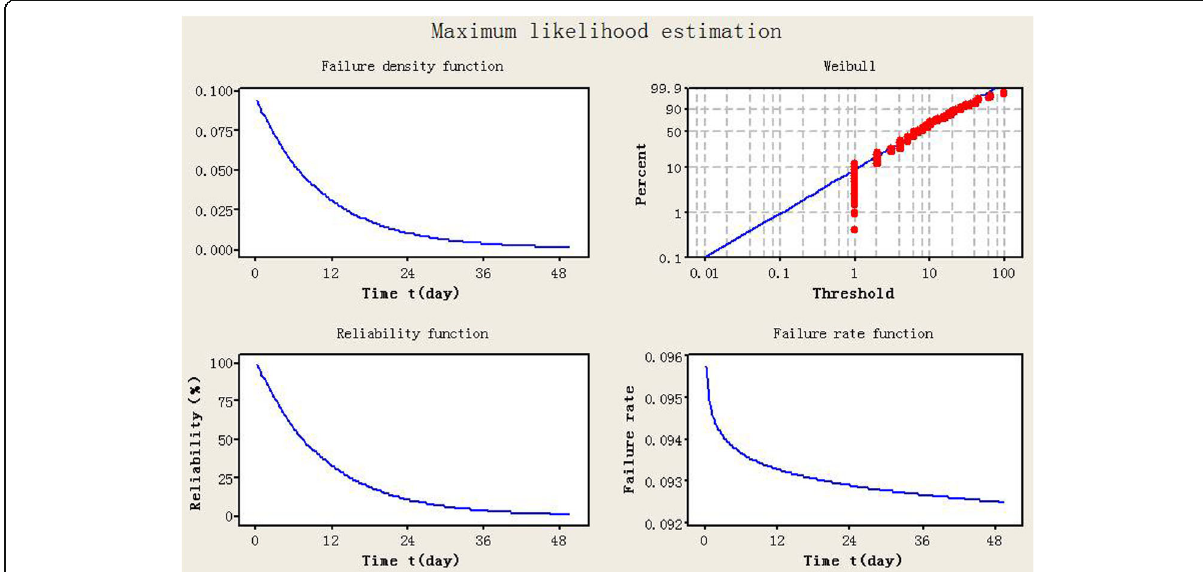
Fig. 5 Reliability characteristic functions of traction